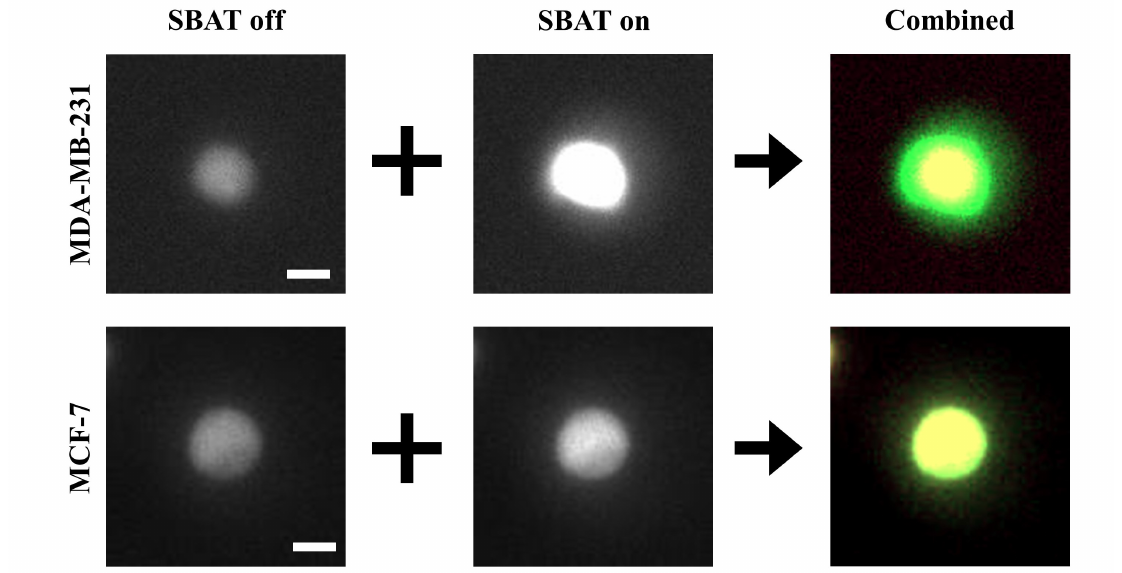
Figure 5. Preprocessing results for fluorescence cell images. When we use the fluorescence dyes, the differences between MDA-MB-231 and MCF-7 are more distinctive than the non-fluorescence ones. The fluorescence cell images barely include noises. These images mostly have black backgrounds. Therefore, as shown in the third column, yellow areas indicate cells before the deformation, and green areas mark changes caused by the deformation. Scale bars indicate 10 µ